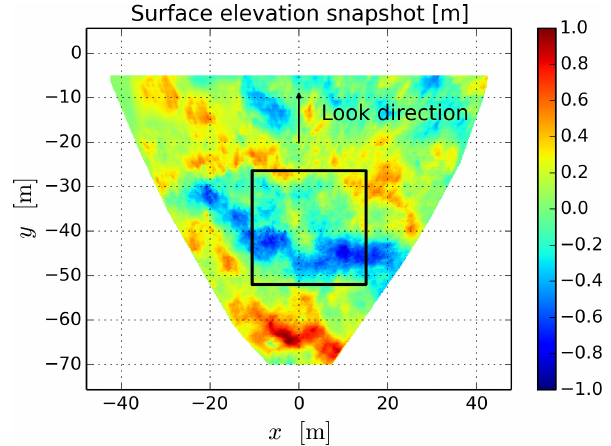
Figure 1. Stereo-video reconstructed sea-surface elevation matrix snapshot and sea-surface area used for spectrum calculations (black